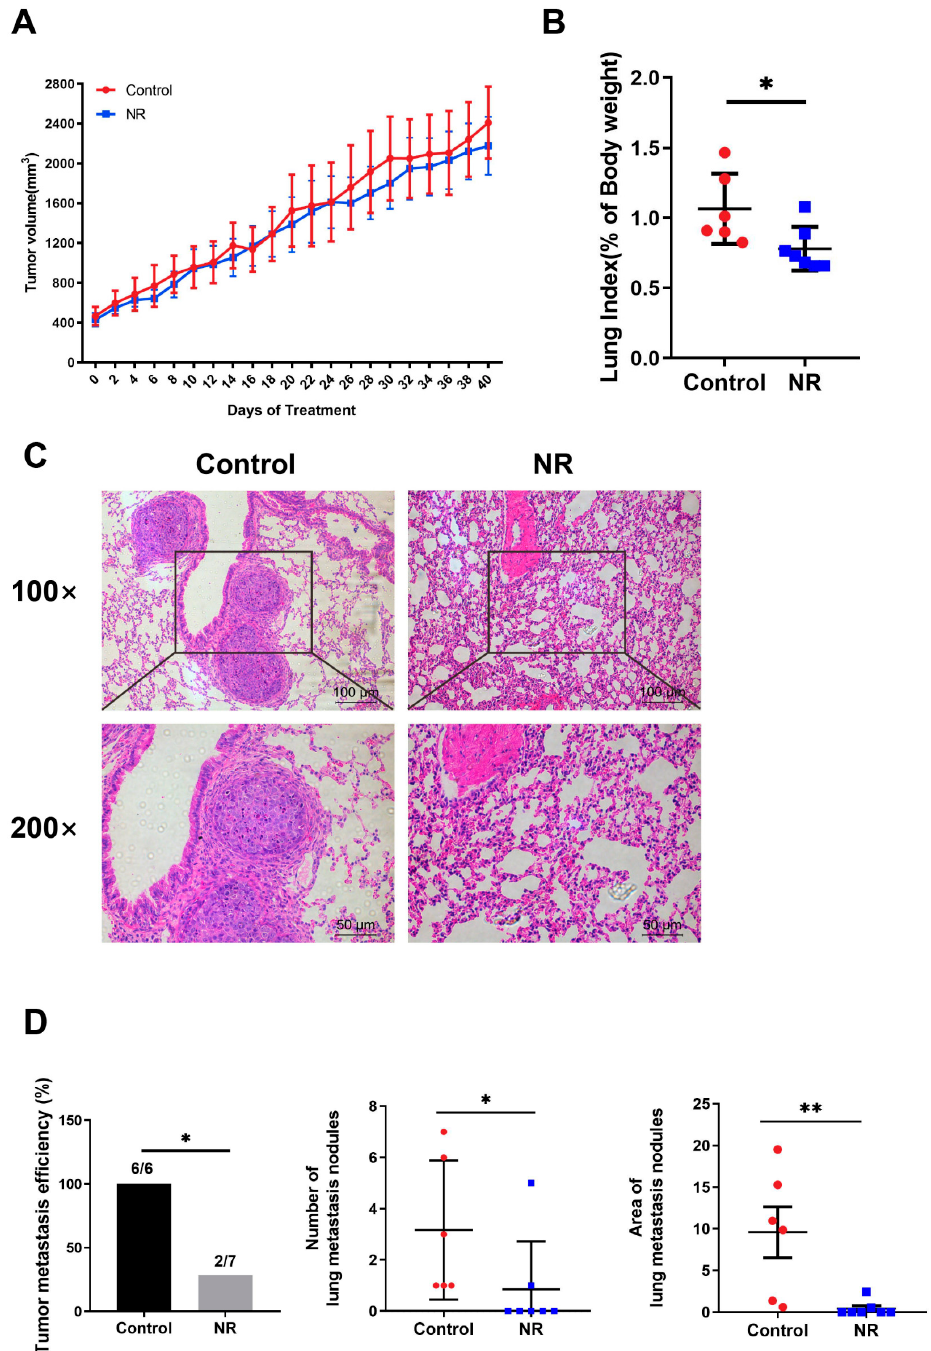
Figure 3. NR supplementation inhibited spontaneous lung metastasis of HCC tumors in mice without affecting in situ tumor growth. ( A ) Changes in subcutaneous tumor growth during the